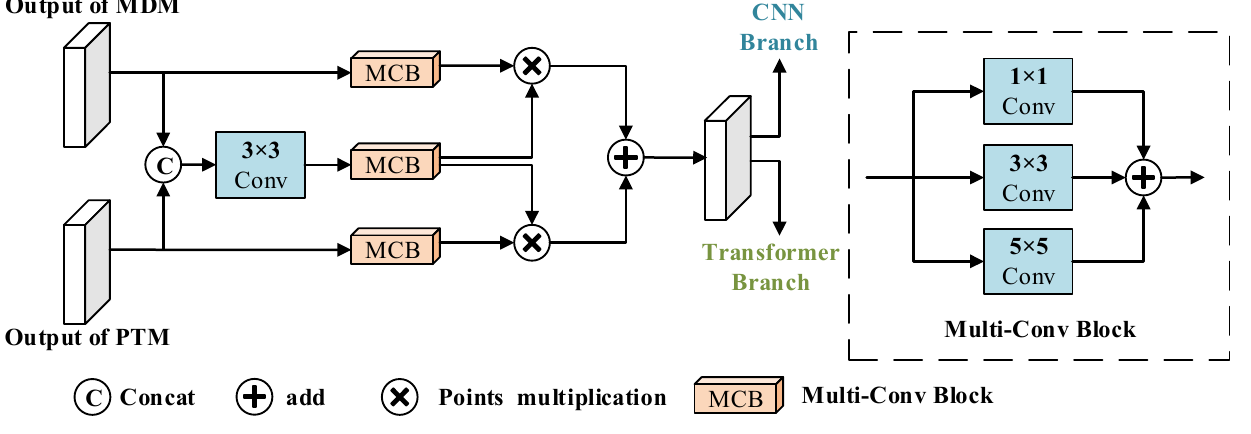
Figure 4. The structure of the FIM.